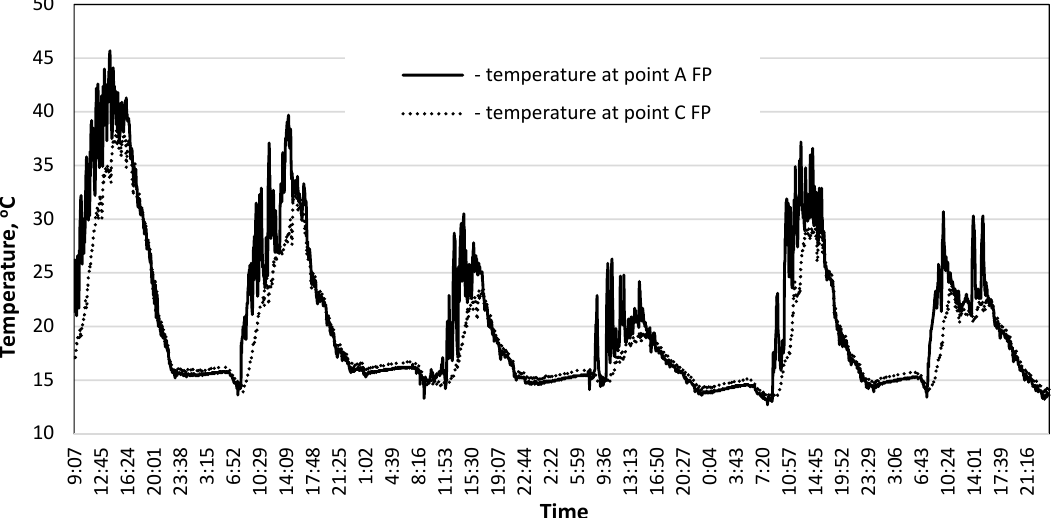
Figure 9. Change of temperature at the beginning of the supply pipe ( A FP —on the roof) and at the beginning of the return pipe ( C FP —in the basement)—circulation loop for flat collectors.